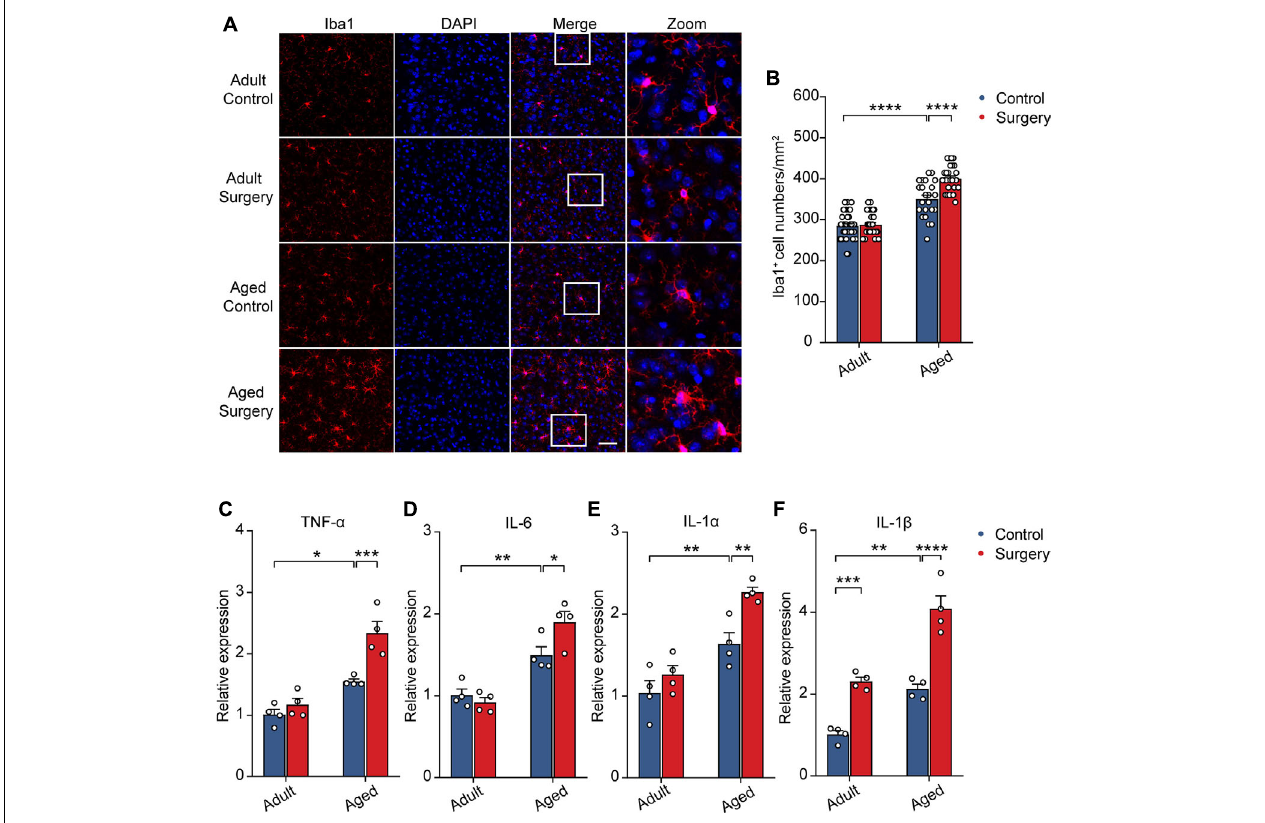
FIGURE 3 | Surgery exacerbated aging-related neuroinflammation. (A) Representative images of Iba1 + microglia in mPFC of the adult and aged mice. Scale bars: 50 µ m. (B) Quantification of Iba1 + cell numbers in each group. (C–F) Expression level of TNF- α (C) , IL-6 (D) , IL-1 α (E) and IL-1 β (F) in each group ( n = 4 mice). Data was presented as mean ± SEM. Data was analyzed by two-way ANOVA and Bonferroni’s correction. *P < 0.05, **P < 0.01, ***P < 0.001, ****P <